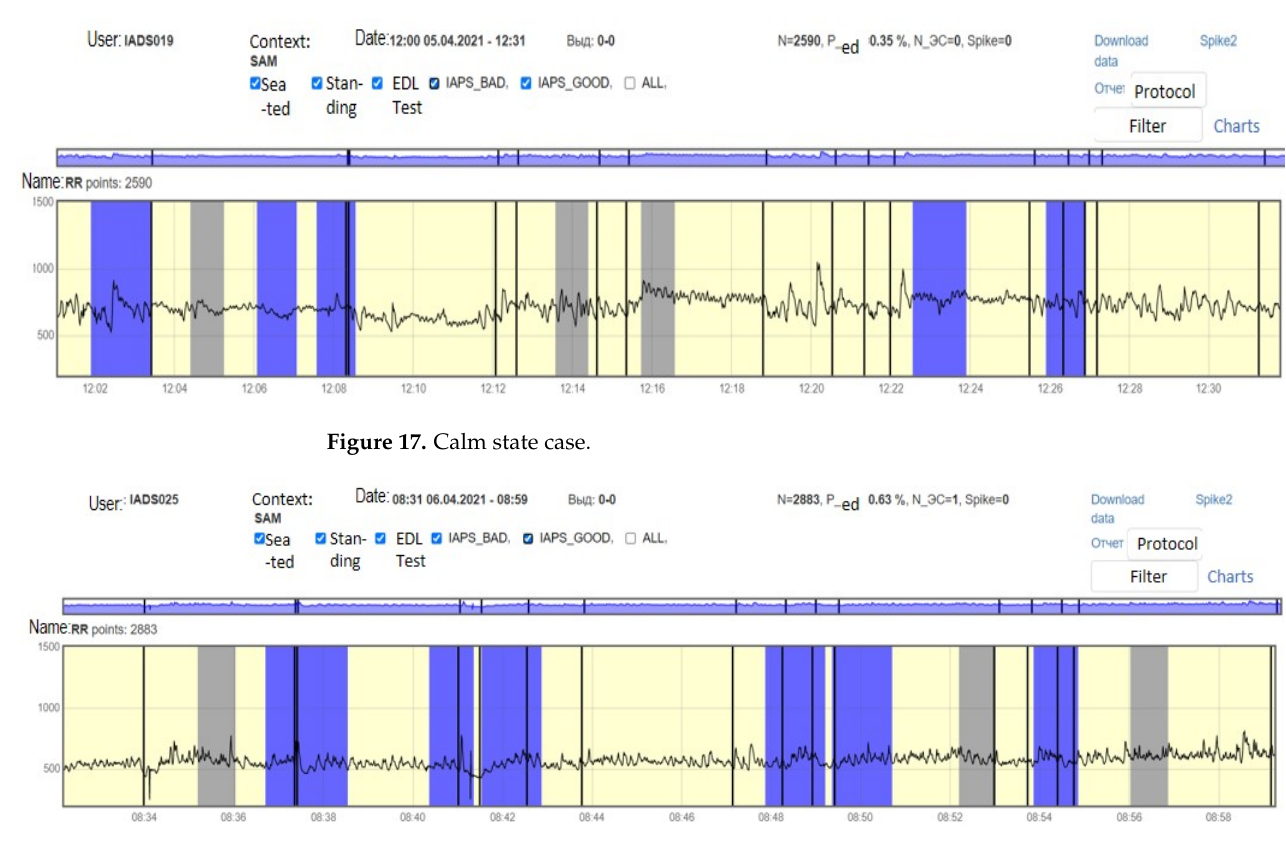
Figure 16. Inversion (optimization) case.